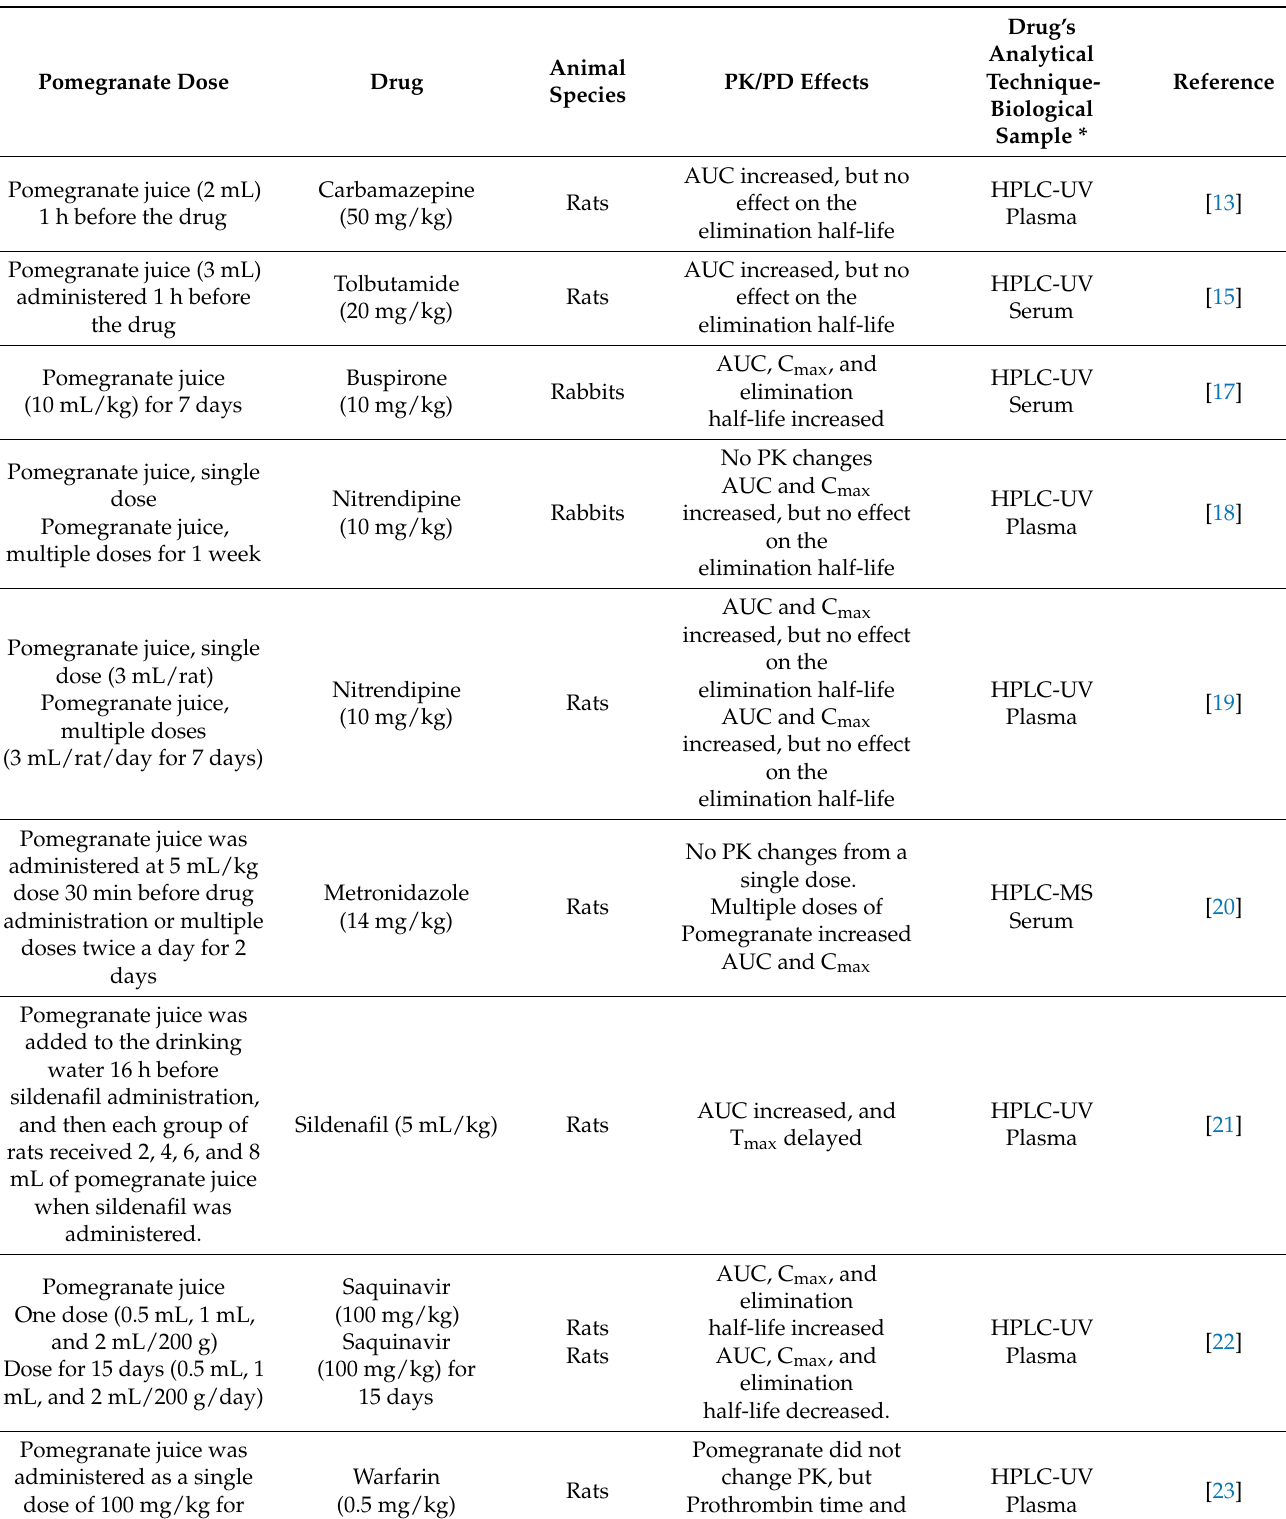
Table 1. Preclinical studies investigating the effect of oral administration of pomegranate juice on